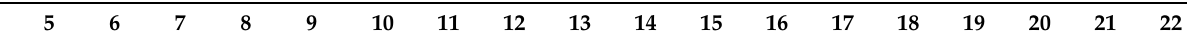
Table 2. Homology analysis of different phytoplasma strains